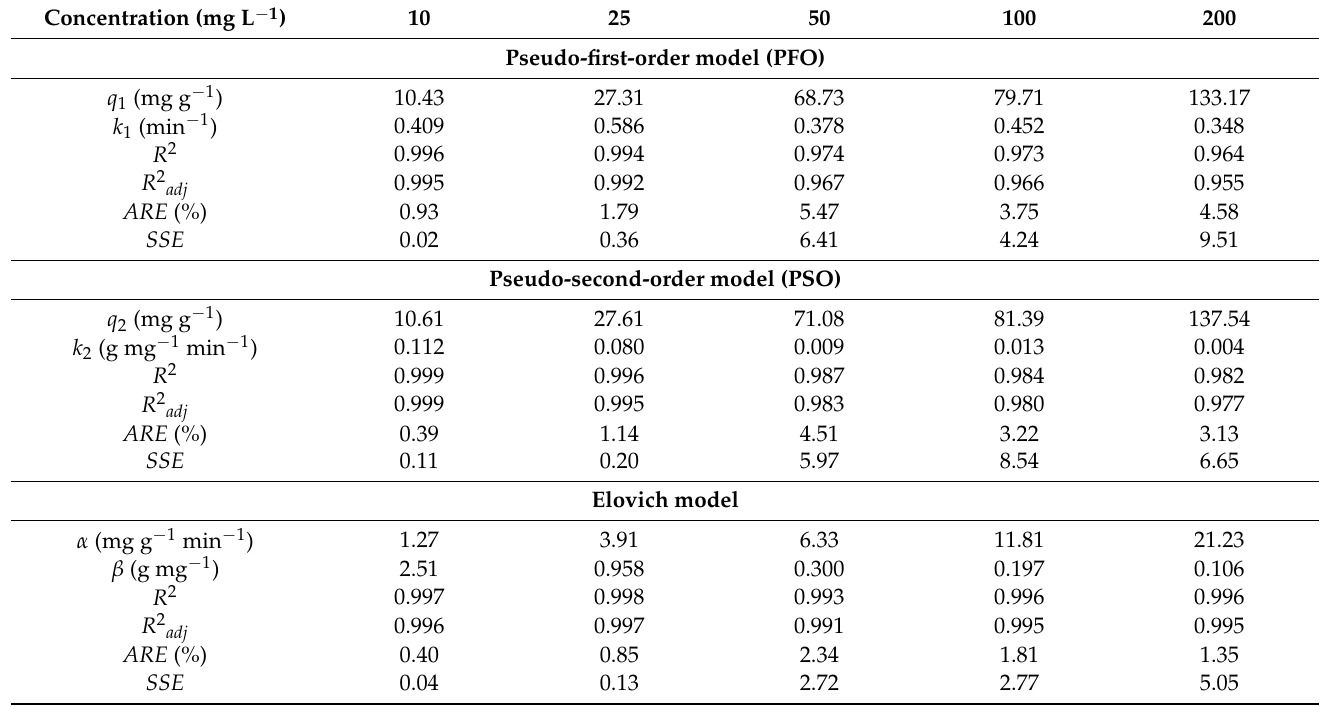
Table 1. Kinetic parameters for tetracycline adsorption on CS·Fe 3 O 4 .